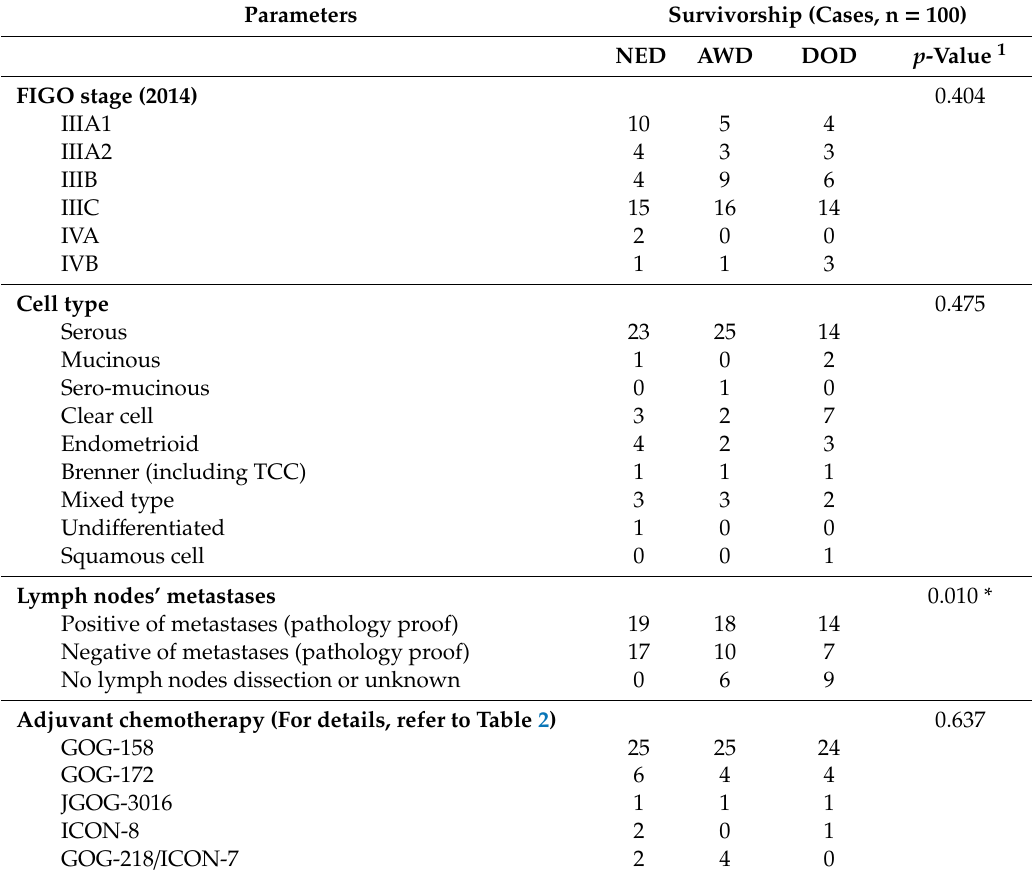
Table 9. Parameters a ff ecting survival in optimally debulked cases.